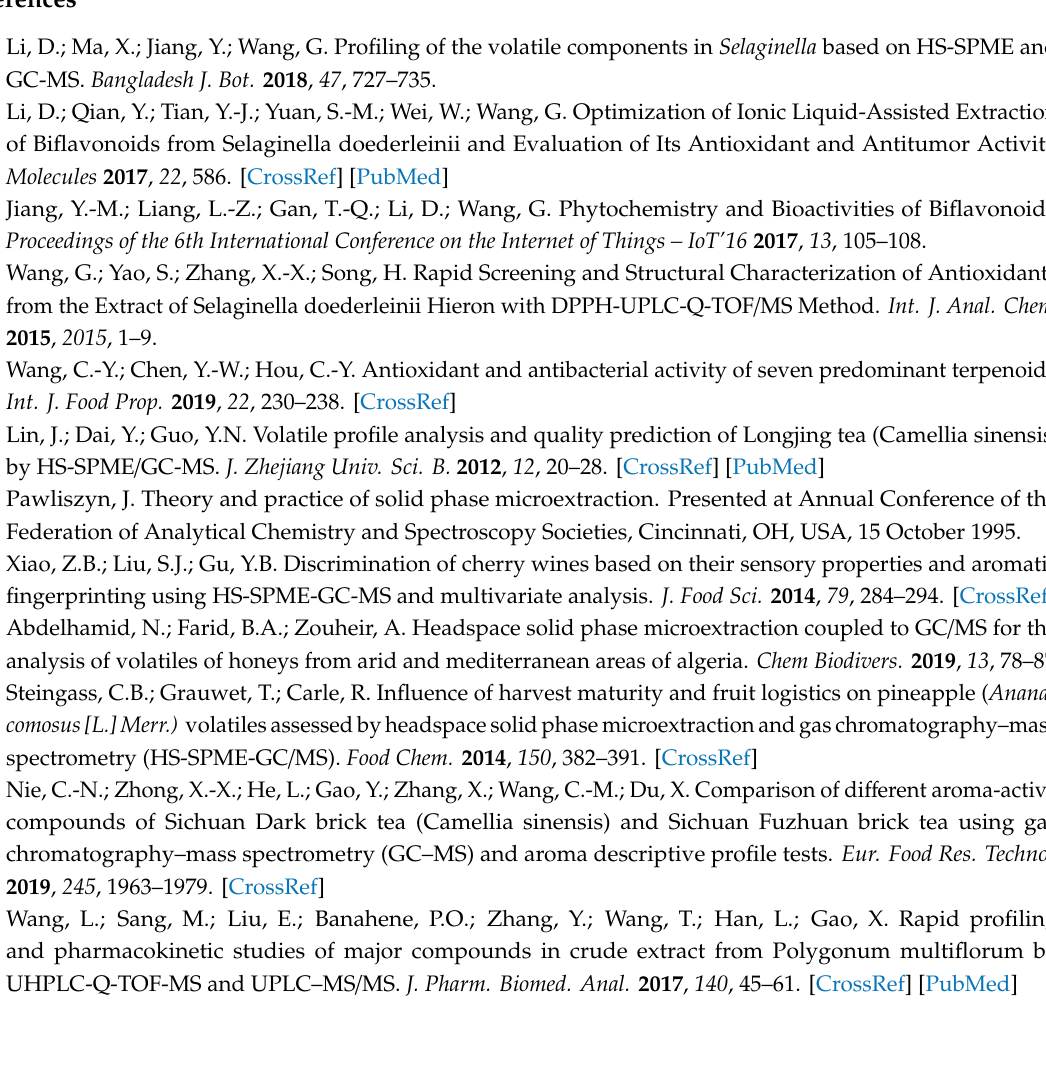
Figure S1. Mass spectrum of peak 19 (A1) and anethol (A2); Mass spectrum of peak 31 (B1) and β -caryophyllene (B2); Figure S2. Mass spectrum of peak 49 (A1) and β -asarone (A2); Mass spectrum of peak 58 (B1) and fitone (B2); Table S1. Sample collection geodata